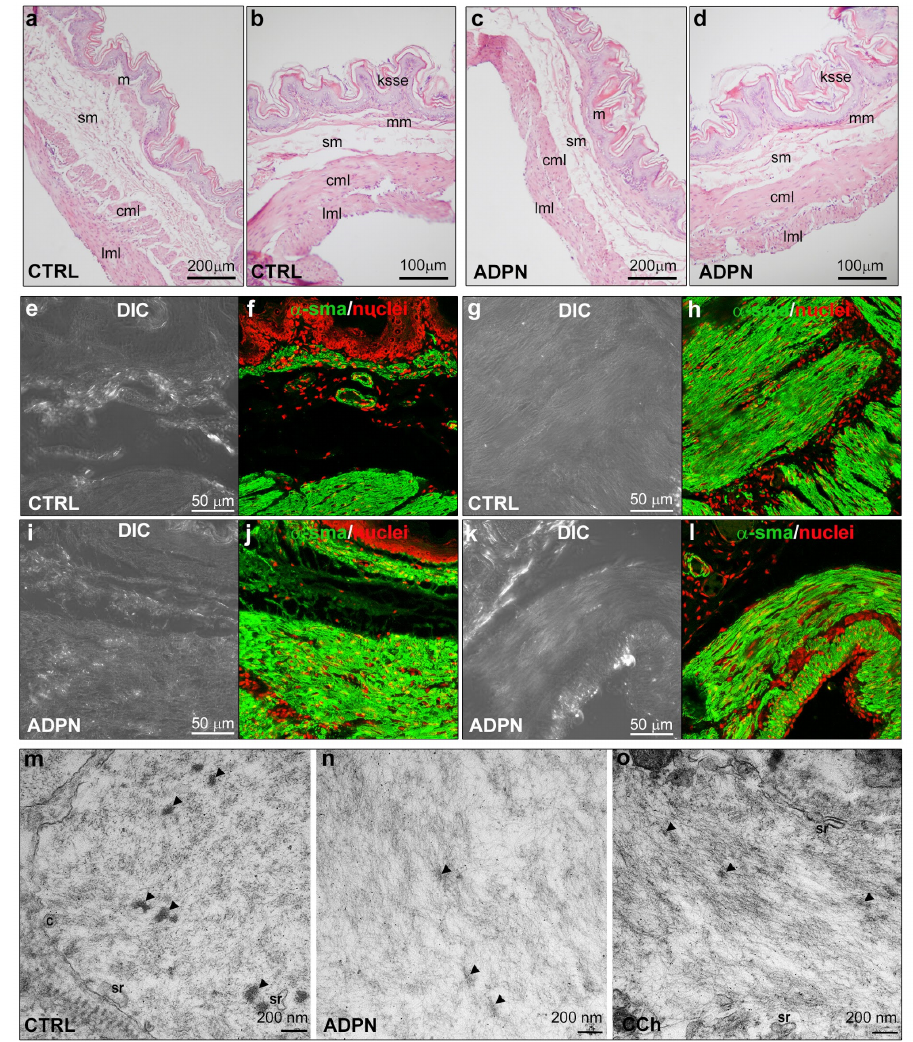
Figure 4. Morphological analyses. ( a – d ) Representative light microscopy images of sections of formalin-fixed and paraffin-embedded full-thickness strips from untreated control (CTRL) and adiponectin (ADPN)-treated murine gastric fundus stained with hematoxylin and eosin (cml = circular muscle layer, ksse = keratinized stratified squamous epithelium, lml = longitudi- nal muscle layer, m = mucosa, mm = muscularis mucosa, and sm = submucosa). Representative ( e , g , i , k ) differential interference contrast images (DIC, grey) and ( f , h , j , l ) relative confocal immunoflu- orescence images showing the expressions and distribution of α -smooth muscle actin (sma) (green). Nuclei are counterstained in red with propidium iodide (PI). Note that immunostaining of α -sma is along the muscularis mucosa, in the blood vessel wall in the submucosa ( f , j ), and in the circular and longitudinal muscle layers ( h , l ). ( m – o ) Representative ultrastructural transmission electron microscopy (TEM) images of the peripheral cytoplasm of longitudinally sectioned smooth muscle cells (SMCs) of the gastric fundus muscle layer from the CTRL, ADPN-treated strip, and strip treated with carbachol (CCh) to stimulate contraction (positive control). ( m ) A CTRL cell shows several bundles of irregularly arranged contractile filaments intermingled with dense bodies (arrowheads). ( n ) An ADPN-treated cell shows a slightly looser network of contractile filaments as compared with the CTRL. ( o ) A cell treated with CCh shows a denser network of contractile filaments as compared with the control. No substantial differences in the amount and morphology of plasma membrane caveolae (c) or sarcoplasmic reticulum profiles (sr) were observed among the different experimental samples ( ×